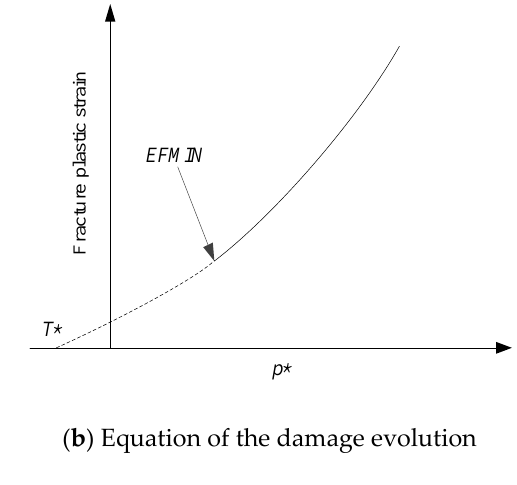
( b ) Equation of the damage evolution